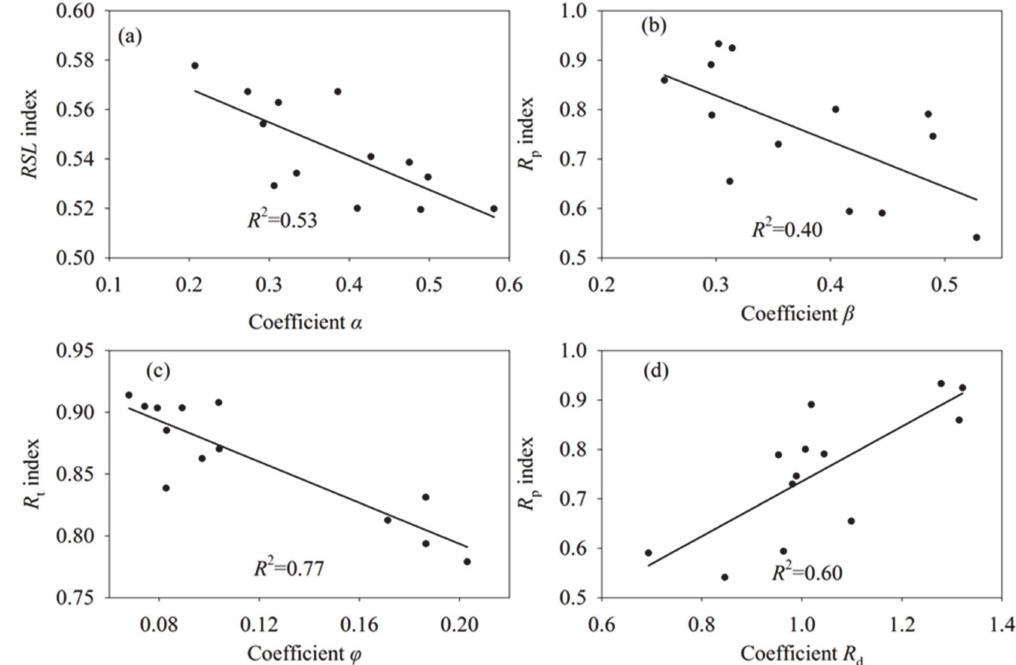
Figure 5. Scatter plot between the resilience index of the new method that proposed by this study and that of the existing methods. ( d ) The coefficient of R d is the resilience index that calculated by the method which based on the ecosystem water use efficiency. ( a – c ) Coefficient α , β , and ϕ was the resilience and resistance index that calculated by the method which based on the annual NDVI and climatic factors (including temperature and drought index) anomalies. ( a ) The coefficient α represents system returns to equilibrium, with large values indicates a low resilience. ( b , c ) While the coefficients β and ϕ represents the drought-resistance and temperature-resistance metrics, respectively. And the large values of coefficient β and ϕ indicate a low resistance to droughts/temperature